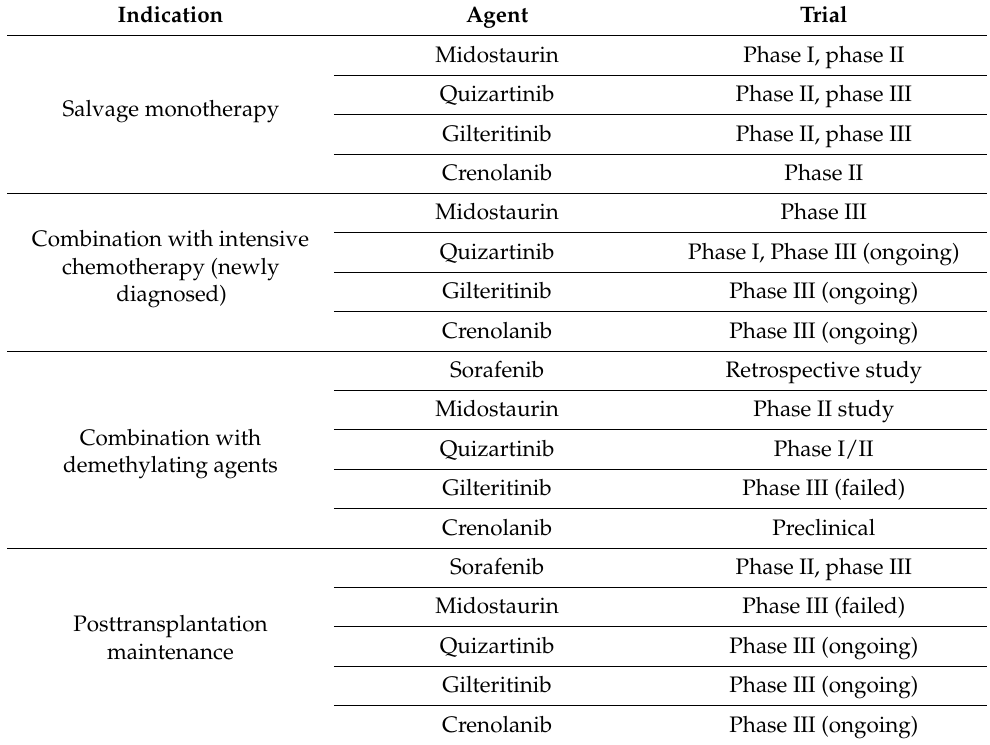
Table 2. FLT3 TKIs. Treatment phase and available